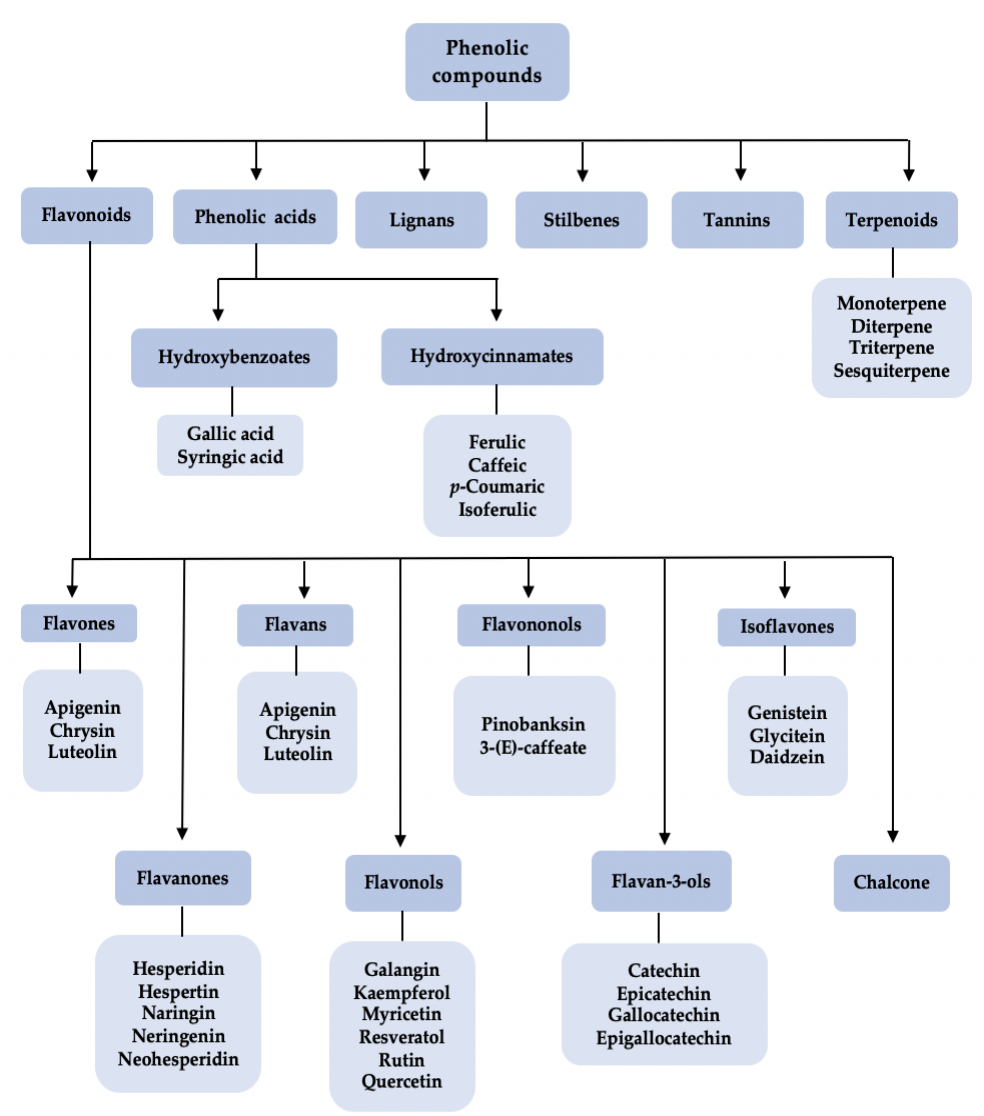
Figure 2. Classification of phenolic compounds.